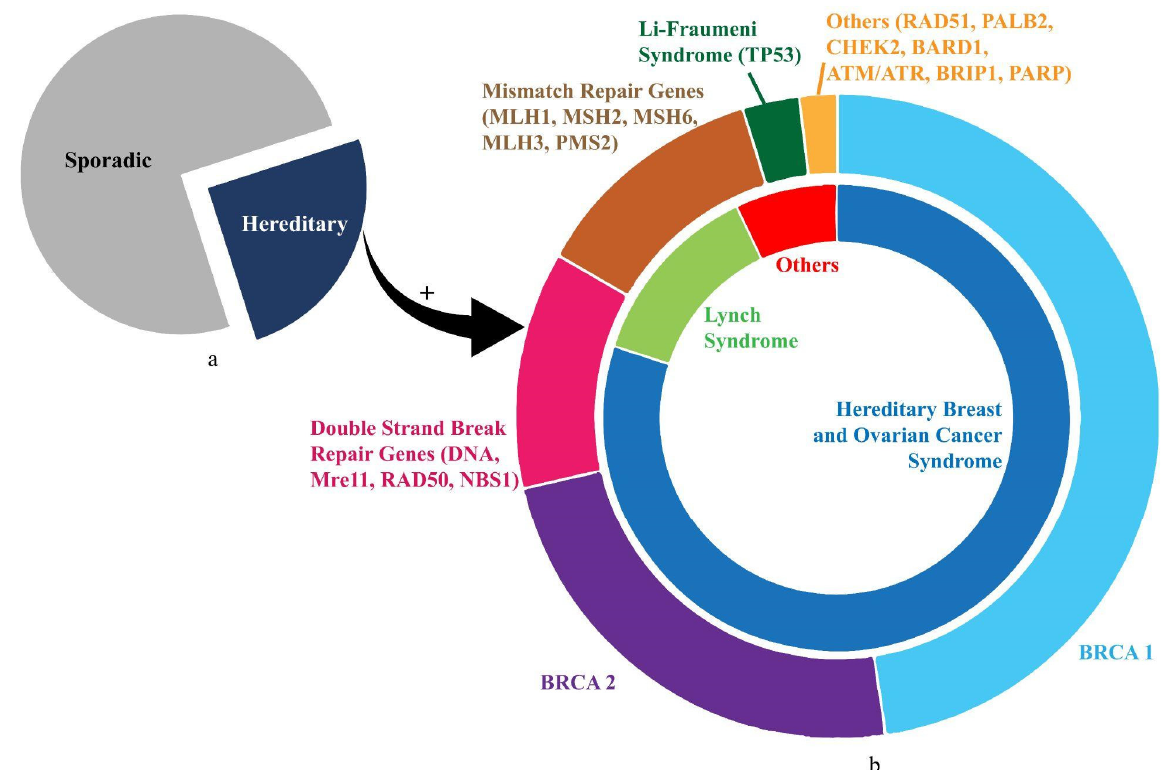
Figure 1. The illustration shows distribution of gene mutations in ovarian cancer. ( a ) Proportion of sporadic (75%) and hereditary (25%) ovarian cancer cases. ( b ) Details of HOC. The inner circle shows the proportions contributed by HBOC and Lynch Syndrome. The outer circle demonstrates the divisions shared by prominent genetic mutations ( BRCA1 , BRCA2 , TP53 ) and mutation groups (mismatch repair genes, double-strand-break repair genes) corresponding approximately to the syndromic association in the inner circle.